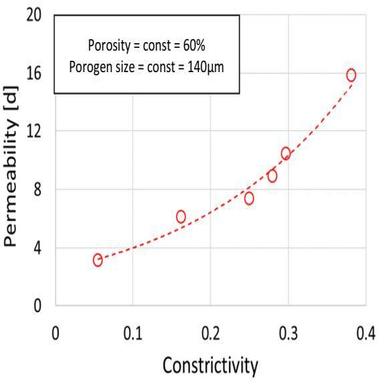
Influence of the constrictivity of the porous structure on materials permeability. Models with the same porosity and porogen size.